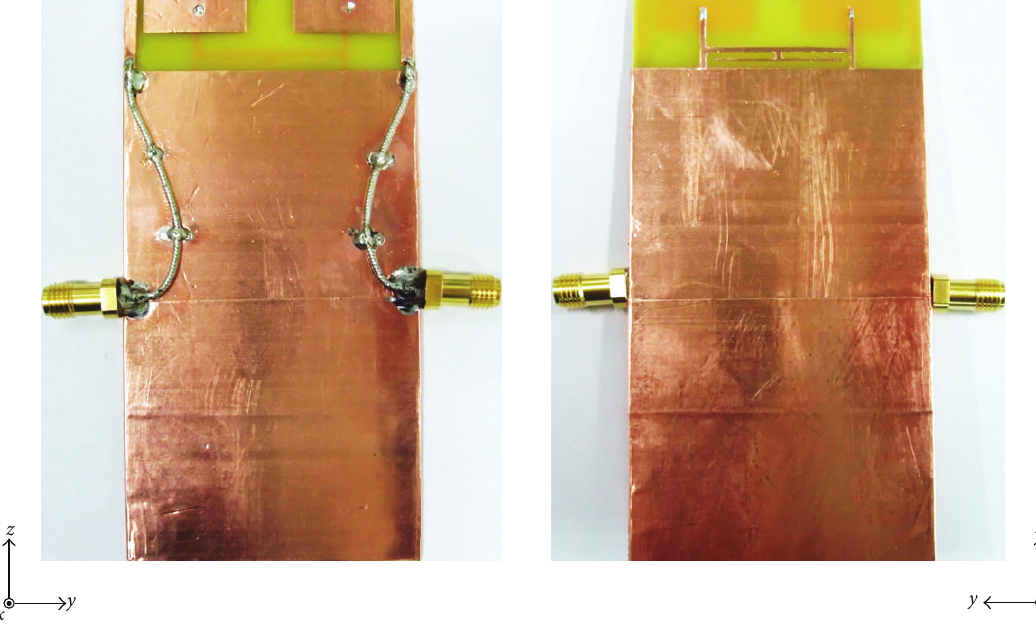
Figure 2: Photograph of the fabricated